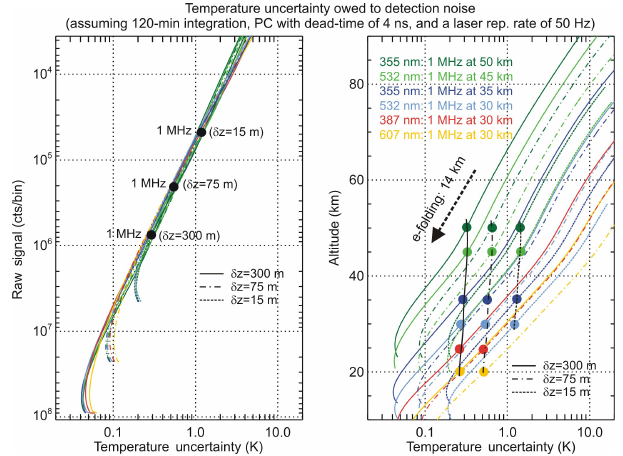
Figure 2. Temperature uncertainty owing to saturation correction as a function of lidar signal magnitude (left) and altitude (right) for a variety of lidar performance configurations (see Fig. 1 caption for